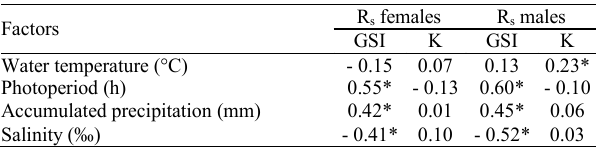
Table 3. Result of the Spearman correlation ( R analyzed environmental factors and the reproductive indices of females and males of E. crossotus in the shallow infralittoral areas of the Paranaguá Estuarine Complex. GSI = gonadosomatic index. K = total condition factor. *Significant values (p <